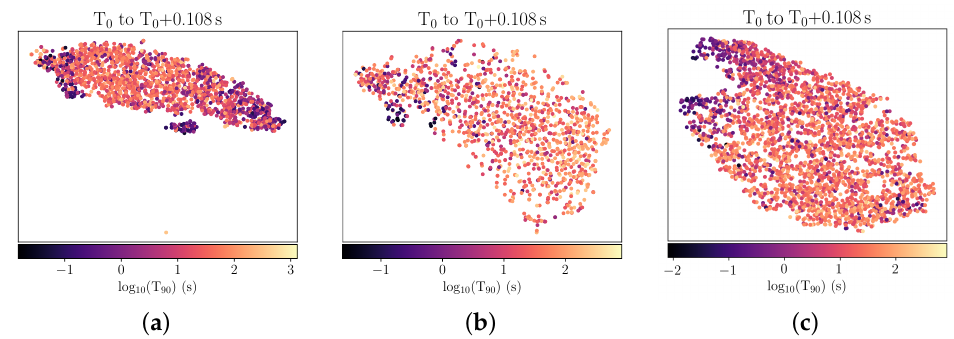
Figure 4. Animation of t-SNE projections for different GRB light-curve time-intervals at 4ms res- olution for ( a ) BATSE ( b ) Swift /BAT and ( c ) Fermi /GBM, coloured by their T 90 duration. The title indicated on the top axis of each figure denotes the analysed time interval, since the burst trigger. The video files are available in the Supplementary